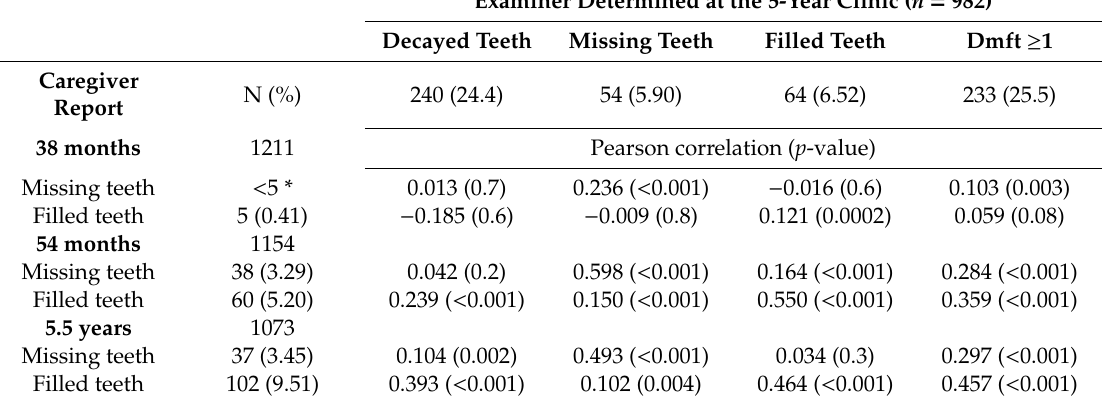
Table 4. Measures of correlation between caregivers’ assessments of children’s dental disease status at 38 months, 54 months, and 5.5 years and clinically determined oral disease status at 5 years of age. Examiner Determined at the 5-Year Clinic ( n =